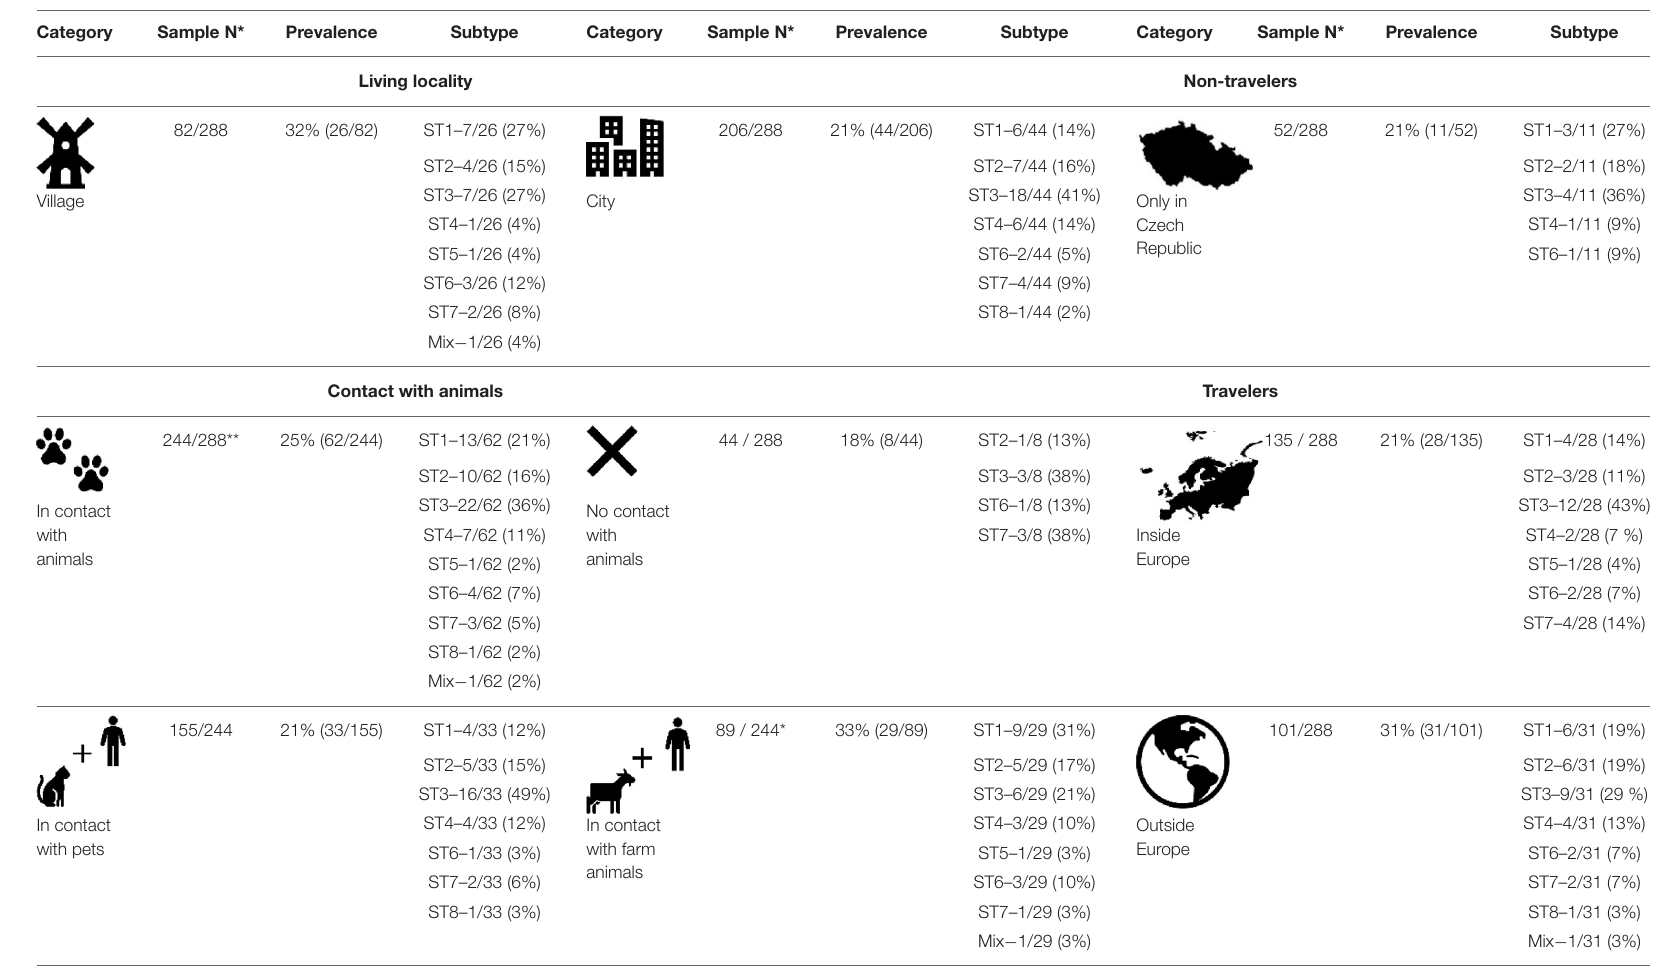
TABLE 3 | Prevalence and subtype diversity of Blastocystis sp. in human samples according to the specific categories such as lifestyle (village vs. city life, traveling) and contact with animals (pets, farm